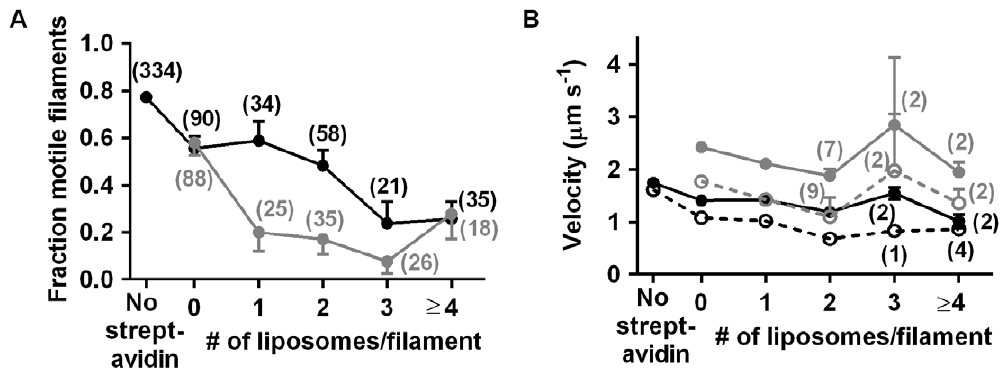
Figure 4. Motility quality vs. number of attached liposomes on HMM propelled filaments. A. The fraction of motile filaments at two different experimental dates (black and grey). B. The sliding velocity. Velocity data represented by black and grey represent two different experiments. The filled symbol and solid line represent velocities obtained from the ten frames running average of the frame-to-frame velocities with lowest CV (CV , 0.5), while the open symbols and dashed line represents the average velocity as described in Fig. 3. The numbers in parentheses represent the number of filaments studied for each condition ( . 10 in B unless otherwise stated). Error bars: SEM. Temperature: 21 u C.